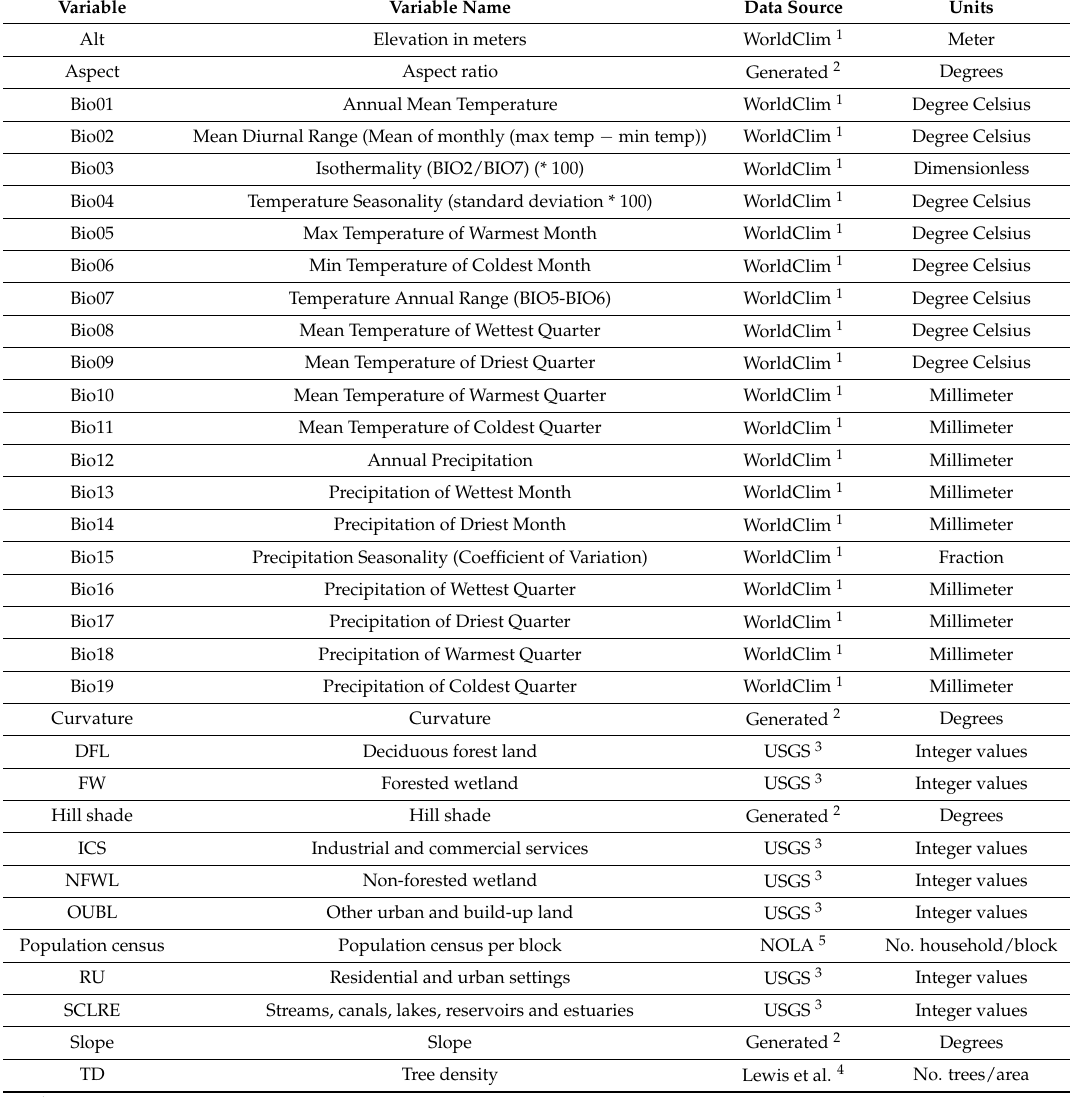
Table 1. Proposed thirty-three variables in prediction model of WNV mosquito vectors in the city of New Orleans,